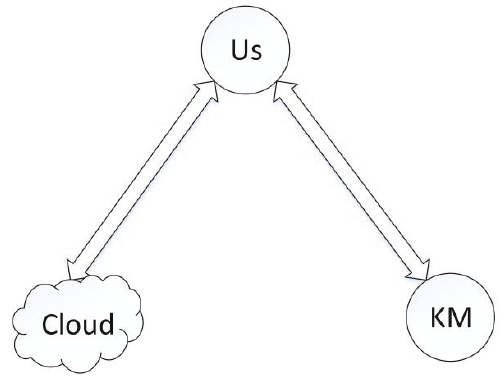
Figure 5. ADSS system model.